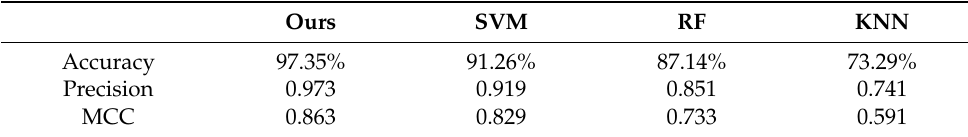
Table 5. Comparison of traditional ML models and